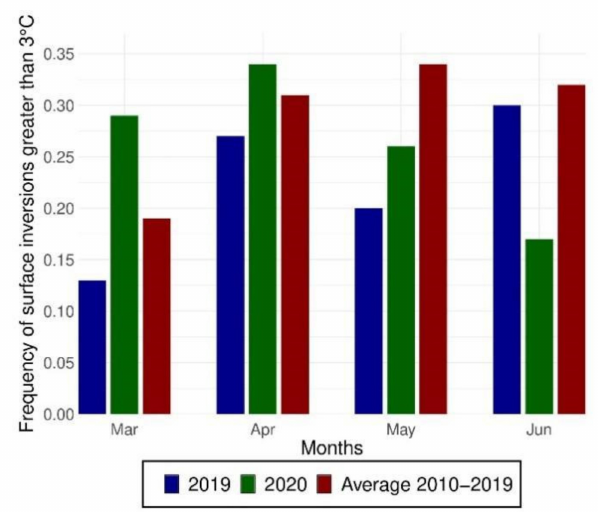
Figure 3. Frequency of surface inversions (temperature gradient greater than 3 ◦ C/100 m) obtained from radiosonde launches at Legionowo weather station 25 km from Warsaw. The blue, red, and orange bars correspond to the springs of 2019, 2020, and to the reference period 2010–2019.